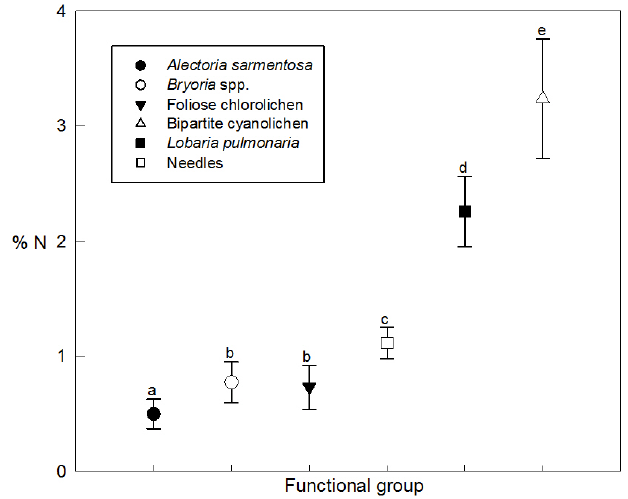
Figure 1. Mean %N (± SD) of lichen biomass in functional groups of lichen and foliage (needle) from 32 spruce and fir study trees with varying amounts of tree-level cyanolichen abundance. Different letters above error bars indicate significant ( p < 0.001) differences between lichen functional groups (Tukey multiple mean comparison